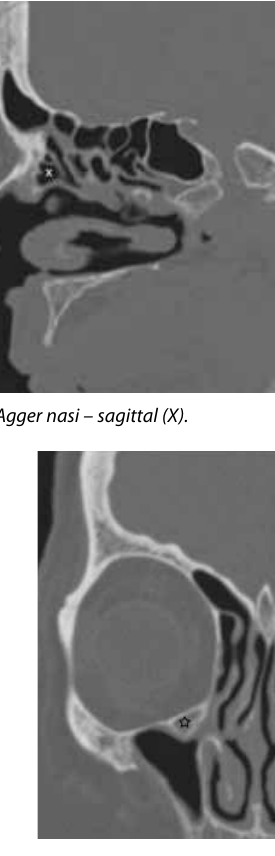
Fig. 6. Intersphenoid septum (arrow).Fig. 5. Haller cells – right (star).Fig. 4. Haller cells – left